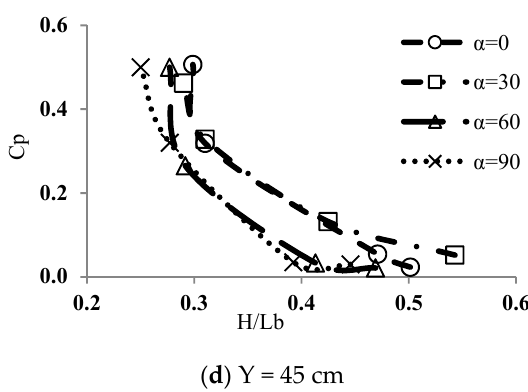
Figure 8. Mean dynamic pressure coefficient versus break-up length at different impact plate angles and plunging depths: ( a ) Y = 0 cm; ( b ) Y = 15 cm; ( c ) Y = 30 cm; and ( d ) Y = 45 cm.